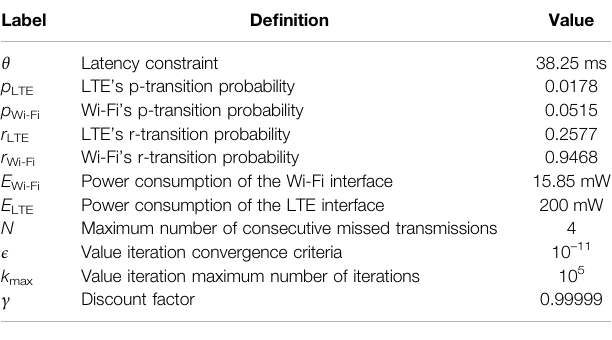
TABLE 1 | Parameters for